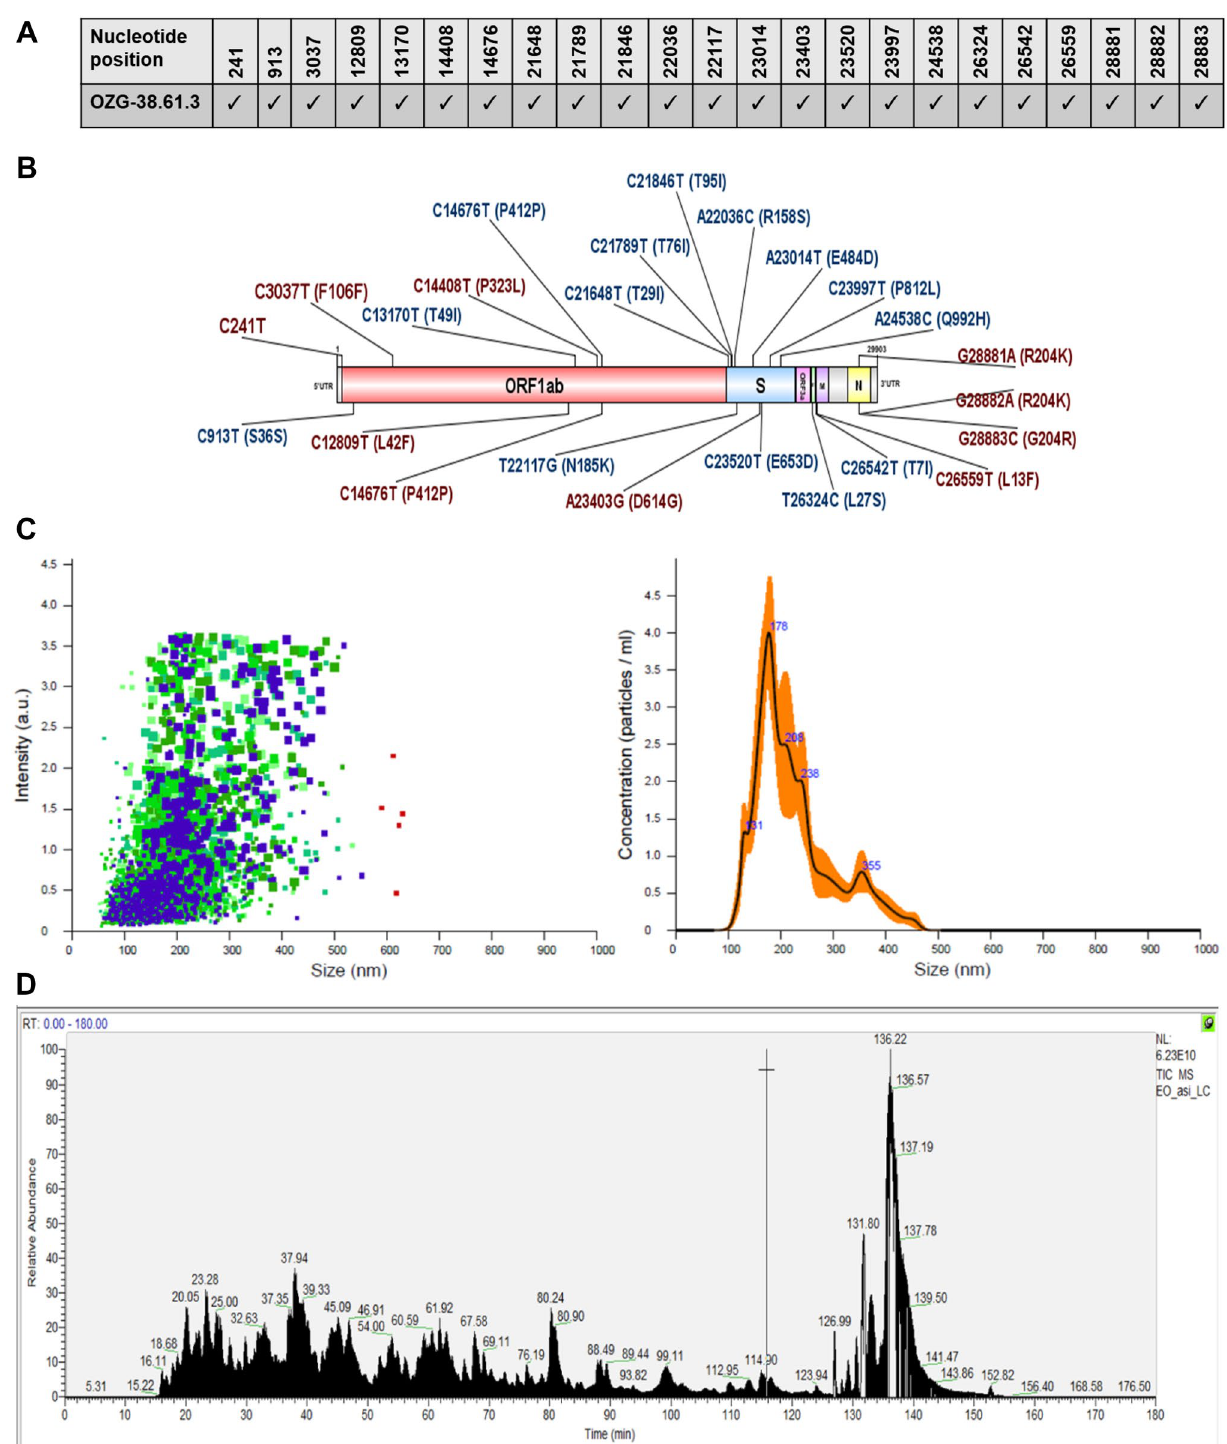
Figure 1. Characterization of inactivated SARS-CoV-2 virus constituting OZG-38.61.3 vaccine candidates. ( A ) Mutation distribution of SARS-CoV-2 virus strain that makes up the OZG-38.61.3 vaccine candidate. ( B ) Representation of variants detected in the virus strain that makes up the OZG-38.61.3 vaccine candidate on the SARS-CoV-2 genome. ( C ) The left plot showing intensity versus the size of the particles in OZG- 38.61.3. The right plot showing the means of particle size of the candidate in the sample read three times. ( D ) Proteome analysis of inactivated OZG-38.61.3 SARS-CoV-2 product. ( E ) TEM image of SARS-CoV-2 Virus. Representative electron micrographs of SARS-CoV-2. Virus particles were seen on the grid (Scale bars: 50 nm, 100